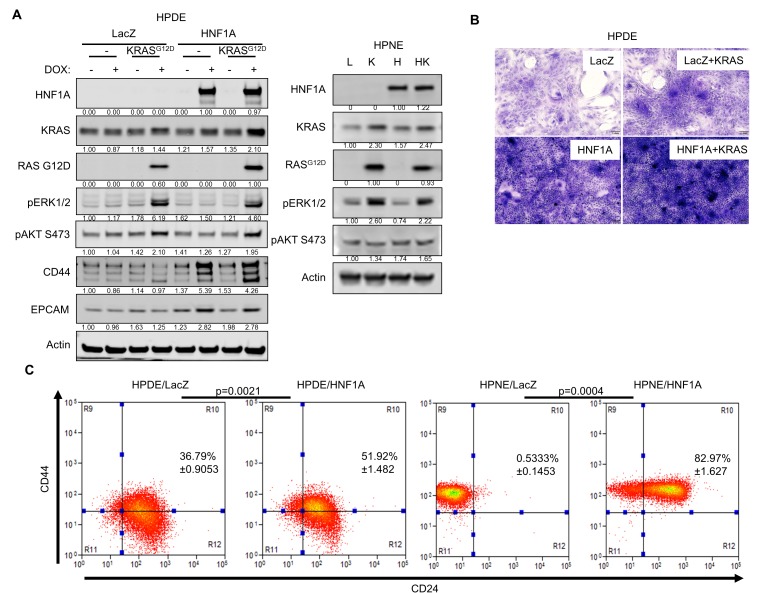
Overexpression of HNF1A and mutant KRAS in HPDE and HPNE cell.(A) HPDE and HPNE cells expressing LacZ (L), KRASG12D (K), HNF1A (H), or HNF1A with KRASG12D (HK) were analyzed by western blot to confirm transgene expression and activation of downstream signaling events. Quantitation of proteins is indicated below the respective blots. For doxycycline-inducible HPDE cells, cells were treated ± doxycycline (Dox) (100 ng/ml) for 7 days prior to analysis. (B) HPDE cells expressing inducible LacZ, HNF1A, LacZ with KRASG12D, or HNF1A with KRASG12D were grown to super-confluency (2 weeks) in the presence of 10% FBS + Dox to test for changes in contact-inhibition. Cells were fixed and stained with crystal violet. Representative images (100X magnification) are shown. (C) Flow cytometry analysis of CD44 and CD24 surface expression on HPDE cells expressing LacZ or HNF1A for 7 days or HPNE cells expressing LacZ or HNF1A. The percentage of CD44+/CD24+ cells is indicated as a mean ± SEM (n = 3). Statistical difference between adherent and sphere cells was determined by unpaired t test with Welch's correction, and respective p values are indicated.